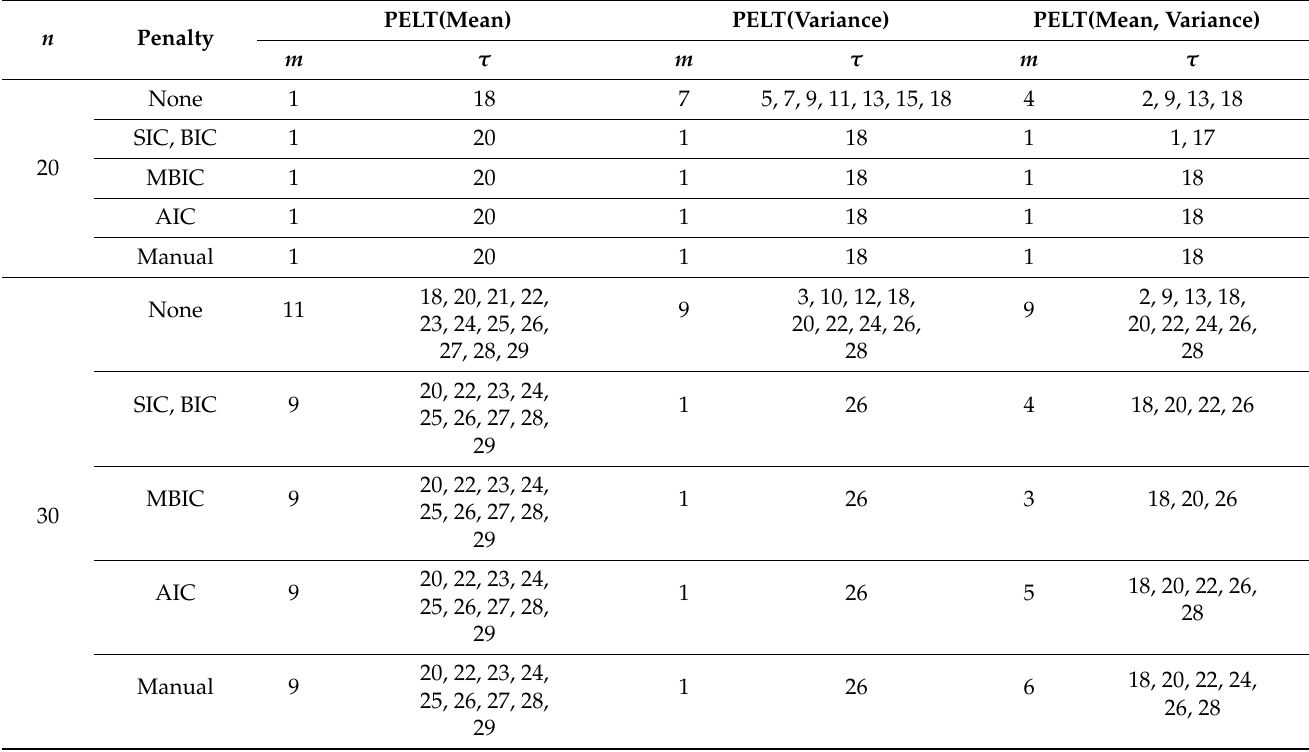
Table A12. PELT Algorithm Result for Poland’s COVID-19 Daily Infection.